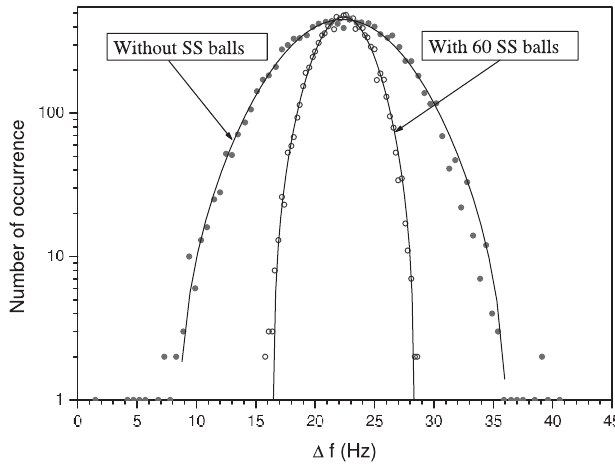
FIG. 6. Frequency excursion ( (cid:1) f ) of a niobium resonator at room temperature without SS ball and with 60 SS balls.